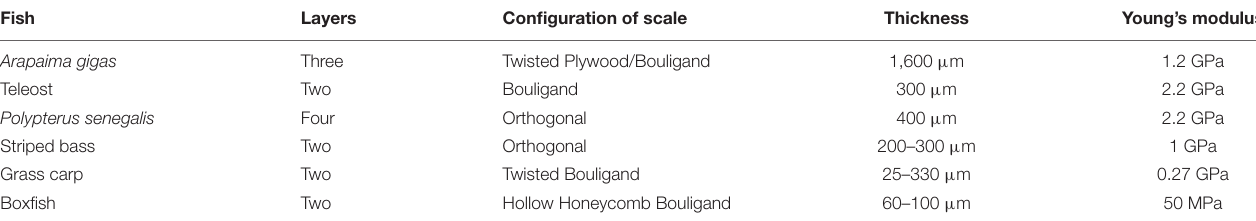
TABLE 2 | Summarized comparison of fish scales and their characteristic.